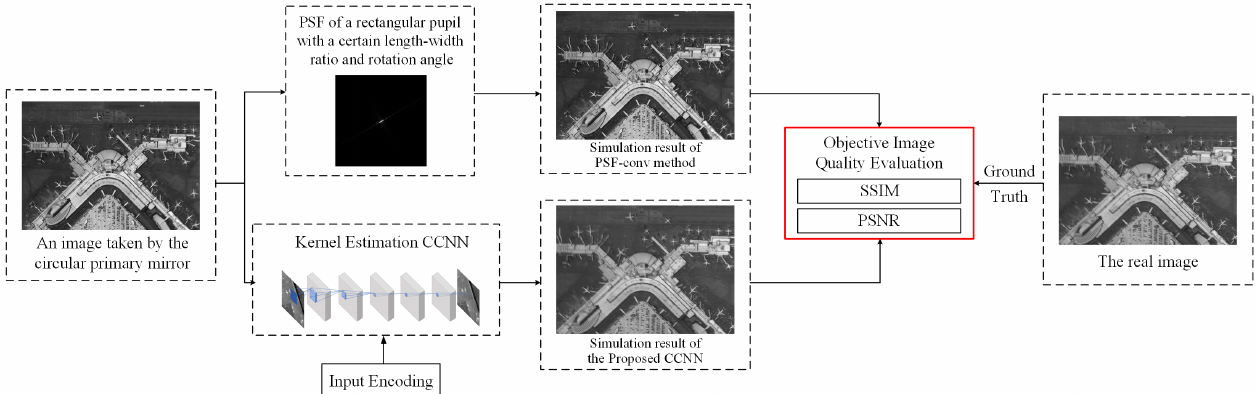
Figure 10. Flowchart of validation experiments.